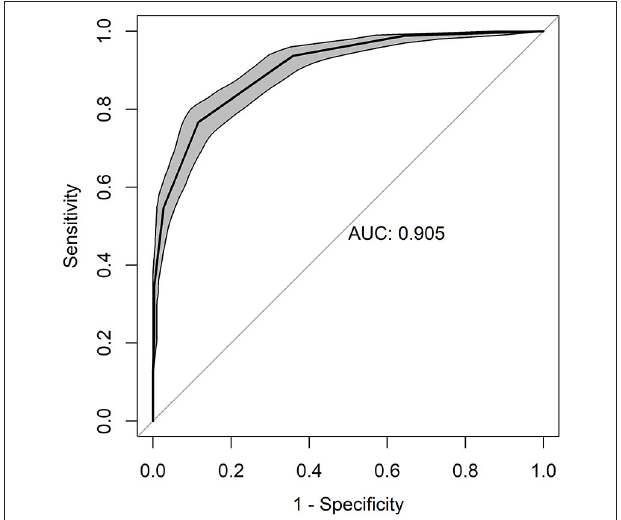
FIGURE 2 | ROC (receiver operating characteristic) curve for the DOPS. Area under the curve (AUC) of